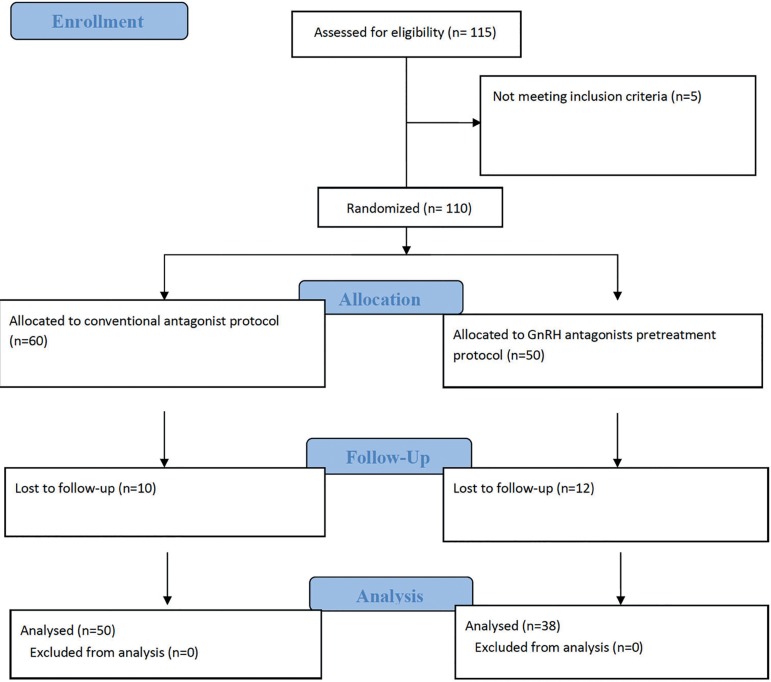
Consort flowchart.